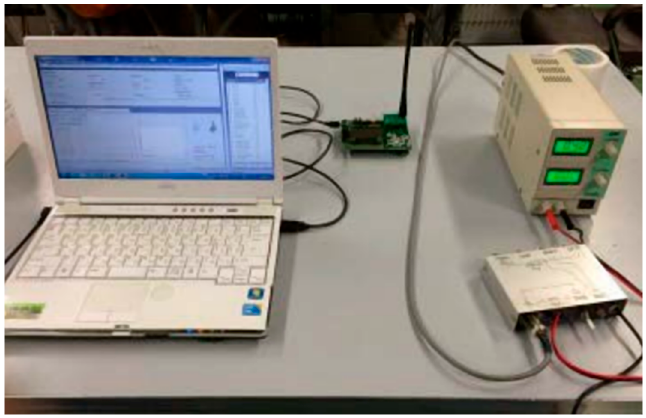
Figure 8. PC for data monitoring during irradiation tests.